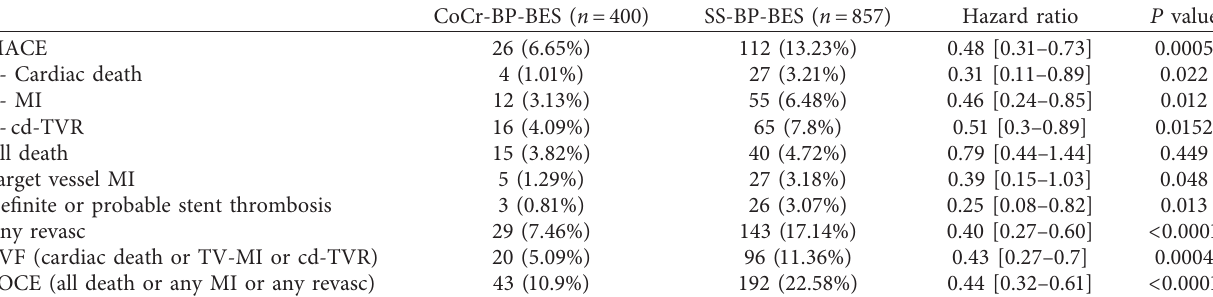
Table 2: Biomatrix Alpha versus LEADERS :unadjusted MACE at 2 years.